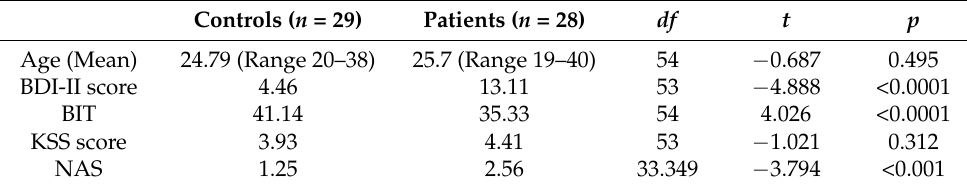
Table 1. Sample description of the two intervention